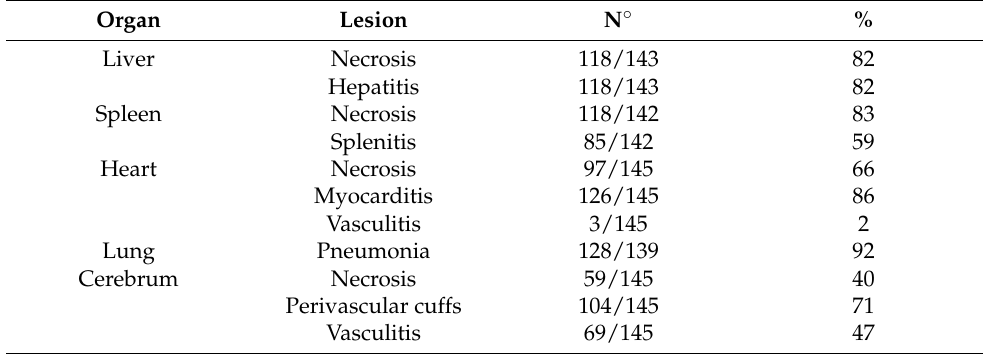
Table 2. Major microscopic findings of liver, spleen, hearth, lung and cerebrum in all the available examined tissues of Eurasian blackbirds, the Netherlands,